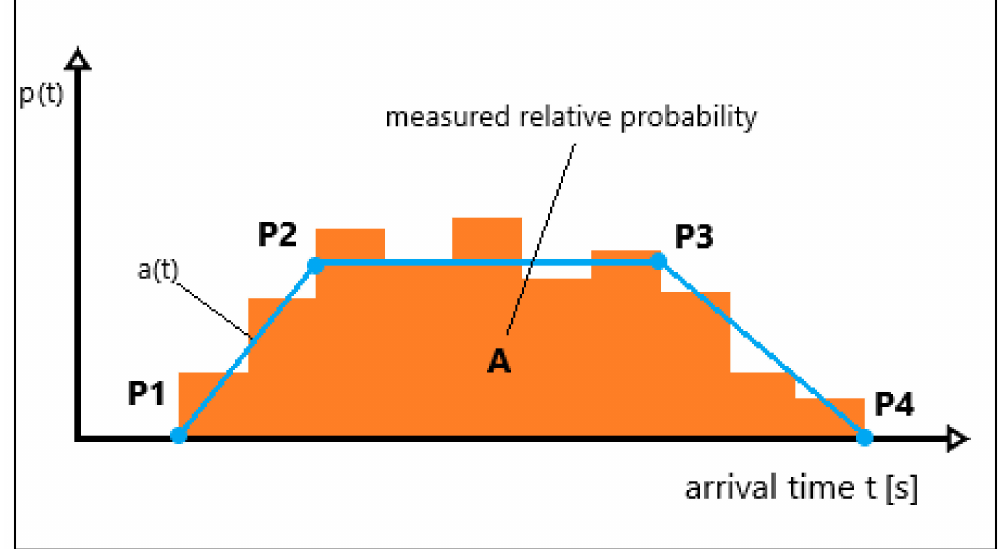
Figure 3. Trapezoidal probability density function of the travel time of a public transport vehicle from the first announcement to the stop line